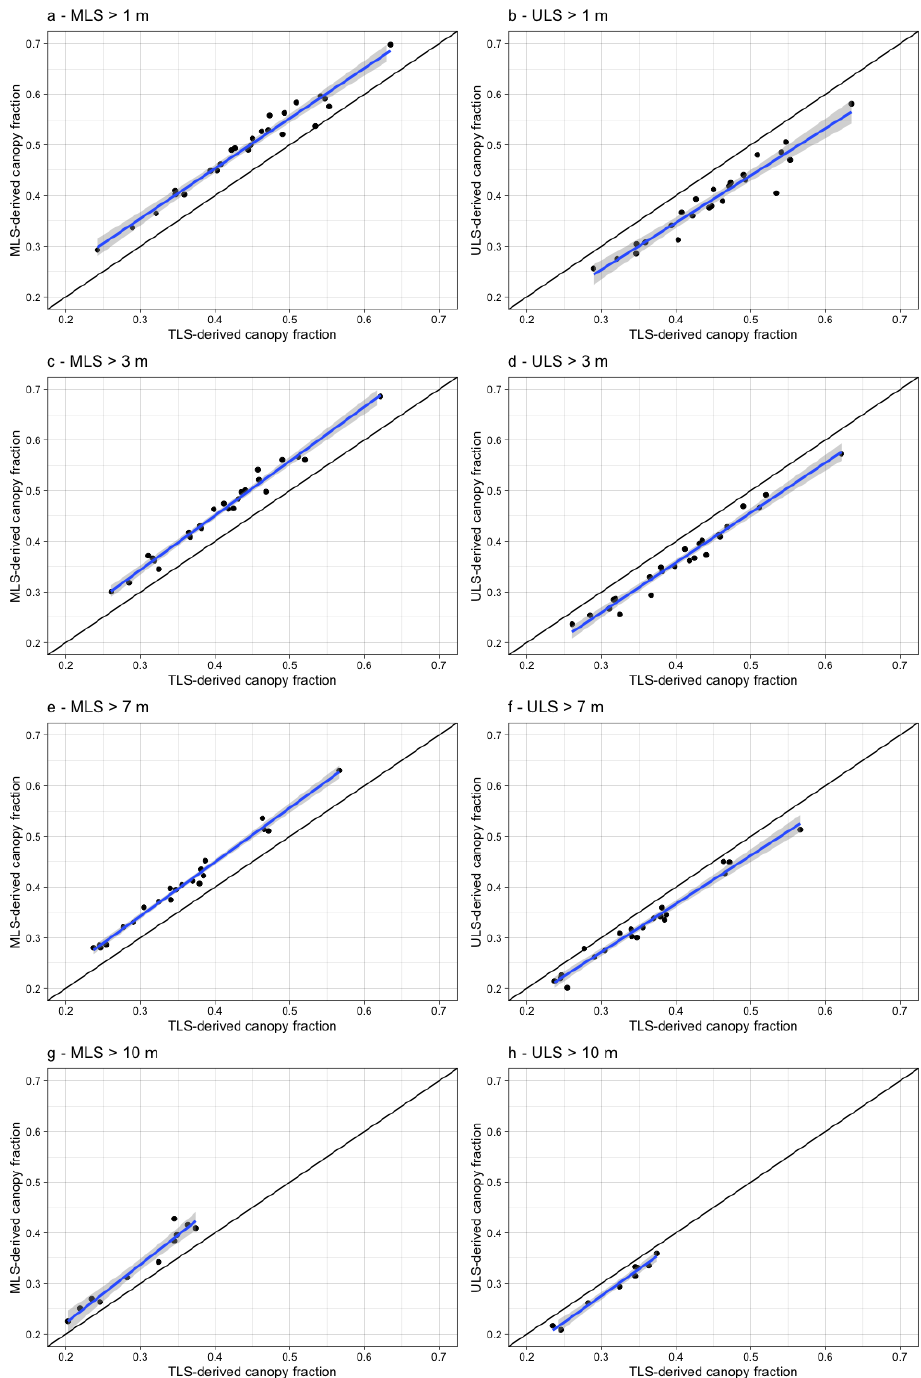
Figure 7. Canopy cover comparisons between MLS and ULS at different height class intervals, against a TLS reference. Solid black is the 1:1